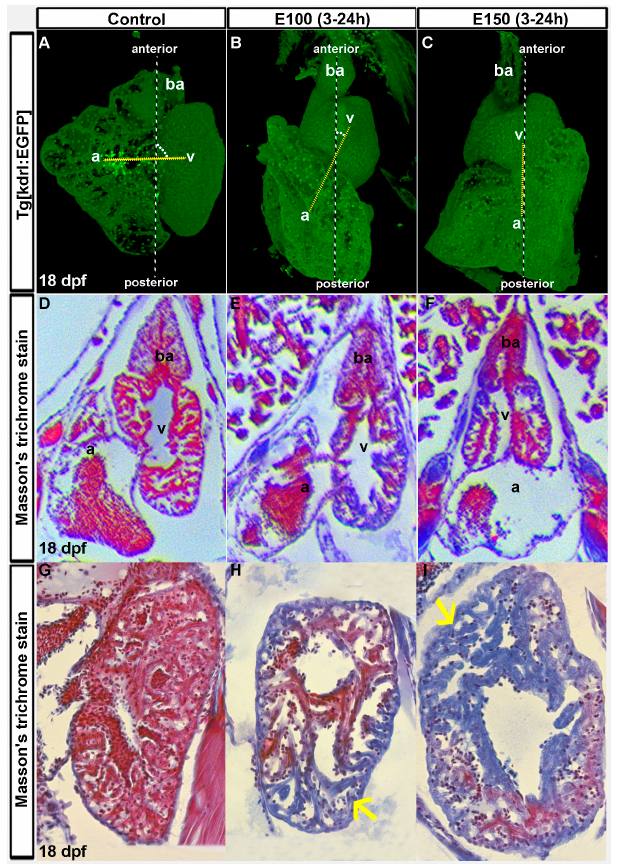
Figure 1. Ethanol-induced cardiac chamber defects occurring during embryogenesis persisted in older zebrafish larvae. ( A – C ) 3D renderings of confocal sections of Tg ( kdrl : EGFP ) show closely attached atrium and ventricle residing side by side in the control larva ( A ); ventricles are on the top of the atria in ethanol-exposed larvae ( B , C ); Dotted yellow line represents the line through AV valves connecting atrium and ventricle. The angle between yellow line and antero-posterior axis is shown by white dots; ( D – F ) Masson’s trichrome stained histology sections at the atrioventricular canal region showing both atrium and ventricle revealed defective anatomy of the ethanol-exposed larvae ( E , F ) compared to control ( D ); ( G – I ) Masson’s trichrome stained histology sections of the ventricle showed healthy looking cardiac muscle (red colored trabeculae) in control larva ( G ); and myocardial damage (blue colored trabeculae, yellow arrows) in ethanol-exposed larvae ( H , I ).